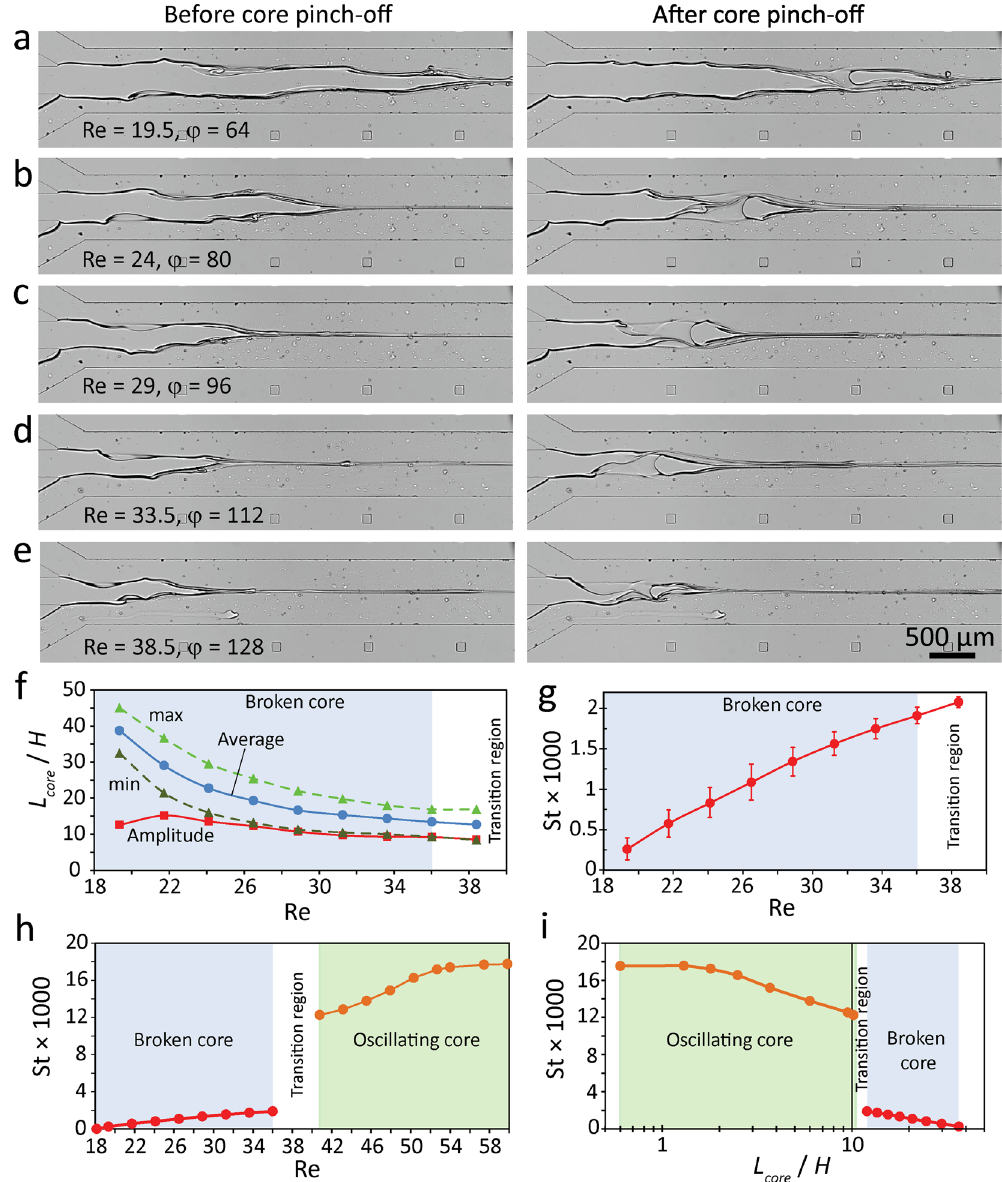
Figure 6. Dynamics of highly viscous core undergoing ‘broken core’ and ‘oscillating core’ regimes: ( a – e ) Extent of the core before/after pinch-off at various Reynolds numbers of 19.5, 24, 29, 33.5 and 38.5 ( f ) Variations of core length ratio against Reynolds number, ( g ) Variations of core Strouhal number against Reynolds numbers for ‘broken core’ regime, ( h ) Variations of core Strouhal number against Reynolds numbers across ‘broken core’ and ‘oscillating core’ regimes, and ( i ) Variations of core Strouhal number against core length ratio across ‘broken core’ and ‘oscillating core’